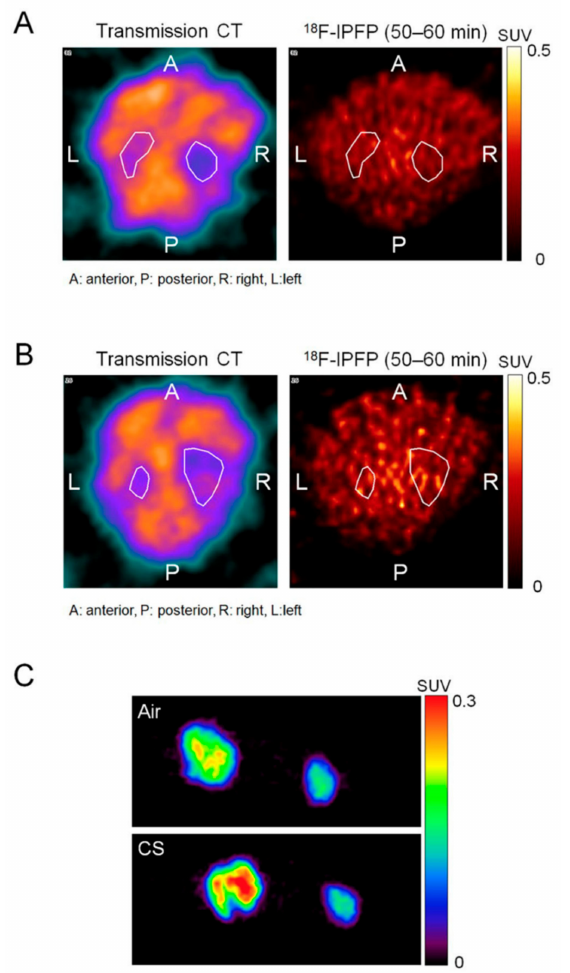
Figure 11. Transverse view of transmission CT and PET images at 50-60 min after injection of [ 18 F] 67 IPFP in the ( A ) Air and ( B ) CS groups. ( C ) Maximum intensity projection images of removed lungs (left) and heart (right) from the Air (upper) and CS (lower) groups. Reprinted with permission from [108] copyright © 2018, Springer